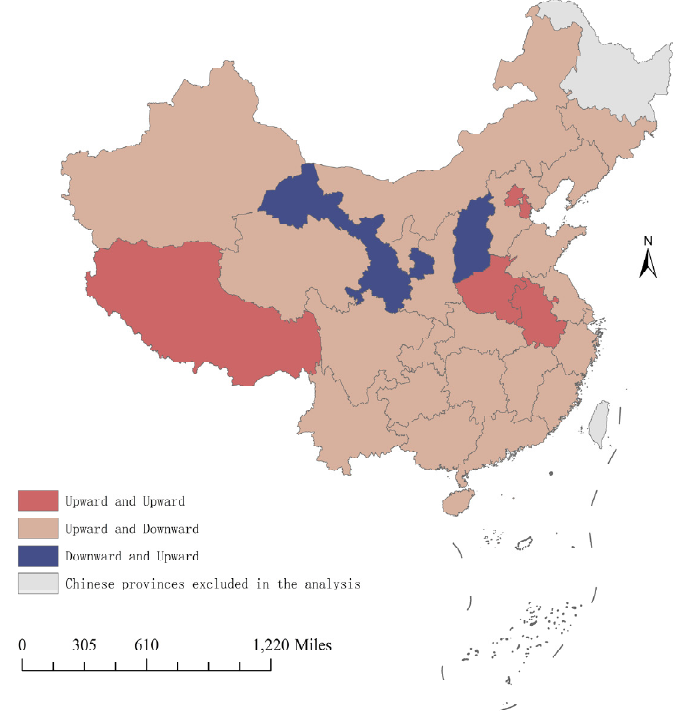
Figure 3. Spatial distribution of the evolution trend of the combined impact. Based on the combined effect status in 2019 (before the COVID-19 pandemic) and the evolution trend, the 30 provinces in this study are categorized into five types. The out- comes and spatial distribution are displayed in Figures 4 and 5.